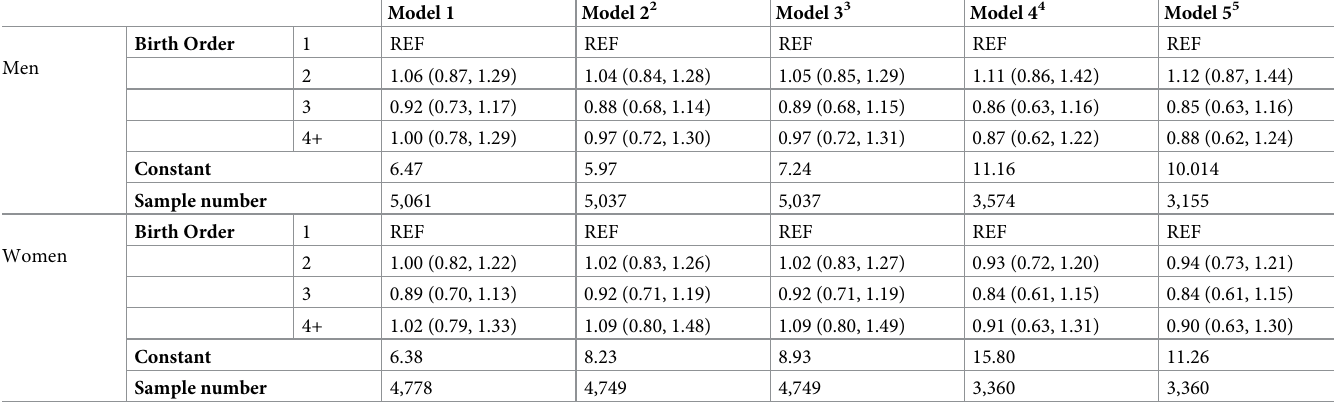
Table 3. Odds ratios from logistic regression models testing the association between birth order and attending a doctor’s consultation in the past year for a mental health issue. Significant values are included in